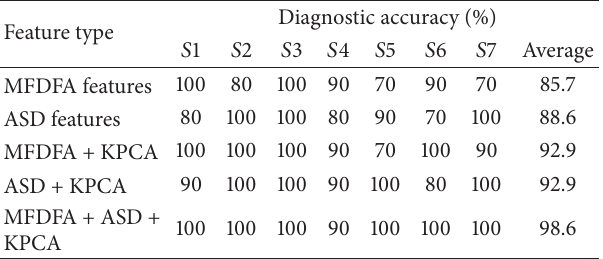
Table 5: The diagnosis results comparison of five